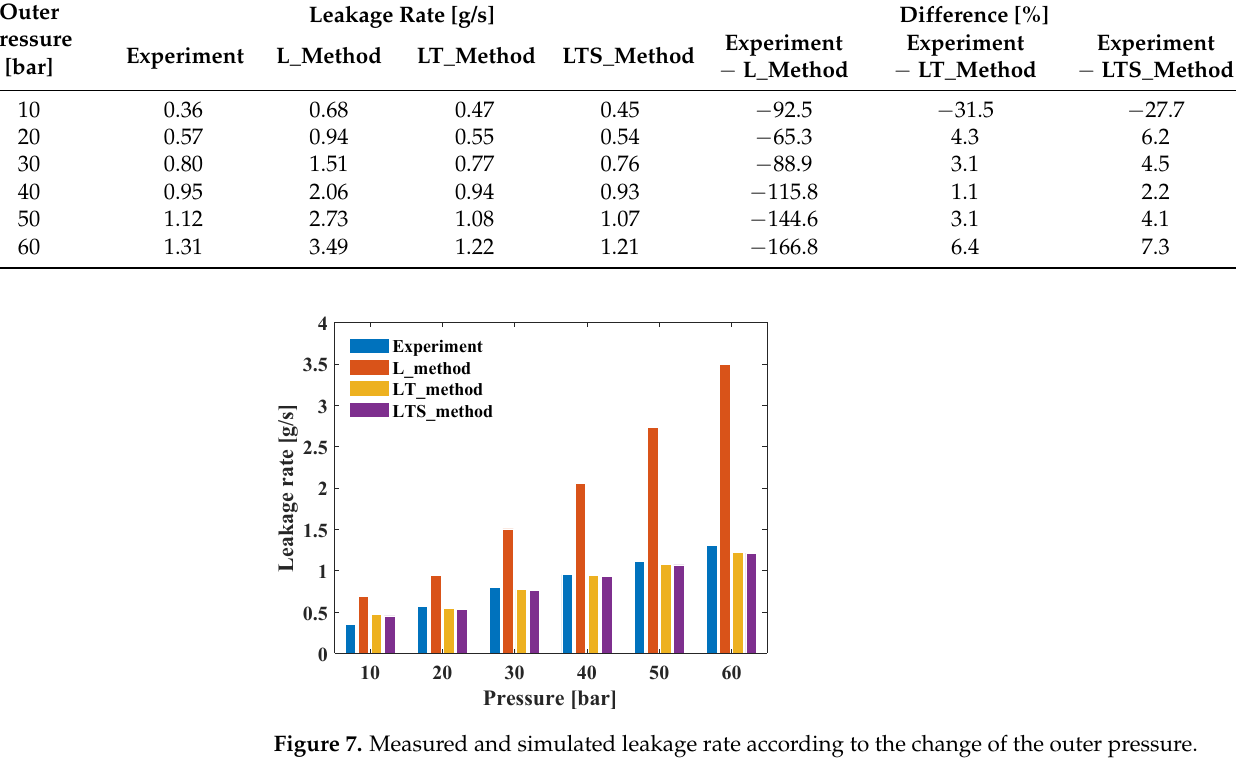
Table 4. Measured and simulated leakage rate according to the change of the outer pressure.